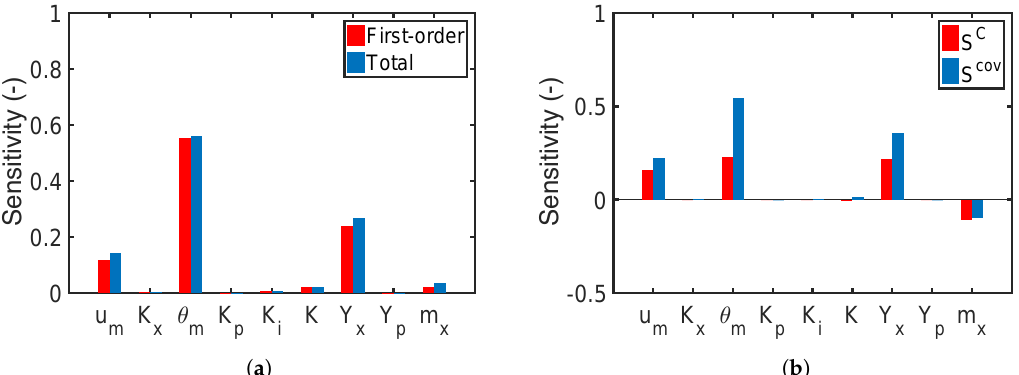
Figure 14. Sensitivity results of nine parameters on the final product concentrations for the independent ( a ) and correlated ( b )